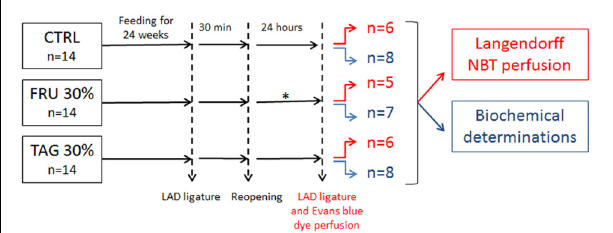
FIGURE 1 | Flowchart of study design. The subgroups of animals represented in red were subjected to left anterior descending (LAD) ligature and nitro-blue tetrazolium (NBT) perfusion. The subgroups of animals subjected to biochemical determinations are indicated in blue. ∗ 2 rats in fructose (FRU 30%) group died after 12 and 15 h of